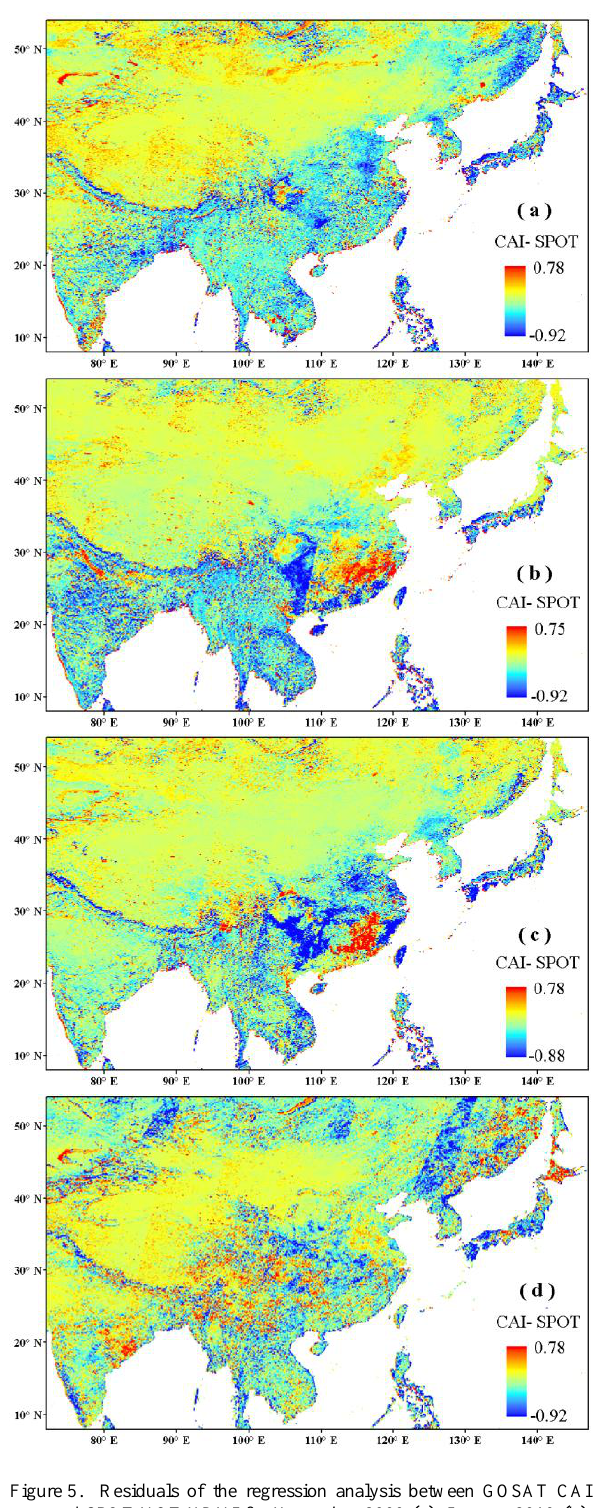
Figure 5. Residuals of the regression analysis between GOSAT CAI and SPOT VGT NDVI for November 2009 (a), January 2010 (b), April 2010 (c) and July 2010 (d). (Blue: GOSAT > SPOT; Red: GOSAT <